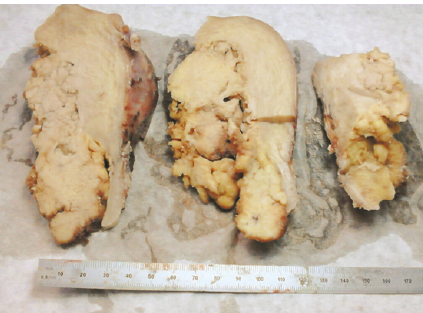
Figure 1: Macroscopic appearance of a cross-sectioned uterus filled with a polypoid papillary mass, extending into the uterine